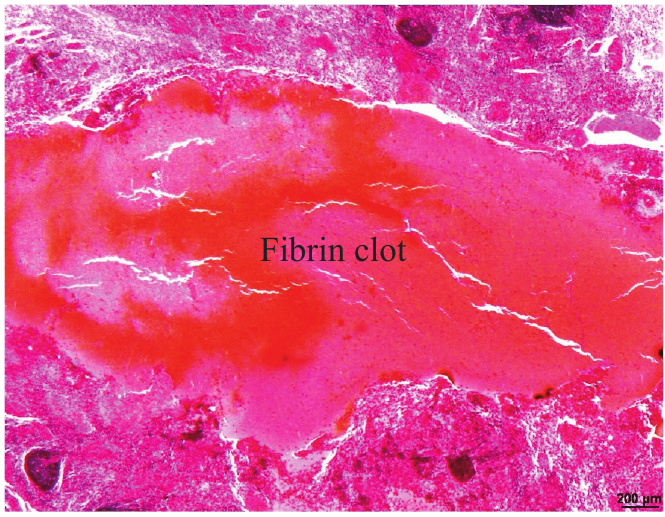
FIGURE 4 - Photomicrography of the fibrin clot occluding the spleen injury (HE –